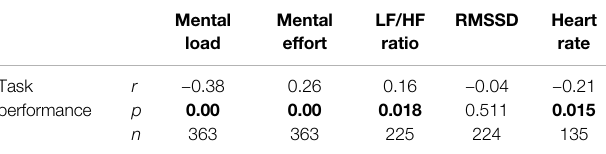
TABLE 8 | Linear regression analysis with variables ASCA, interest and perceived stress as predictor variables for mental load (for the total